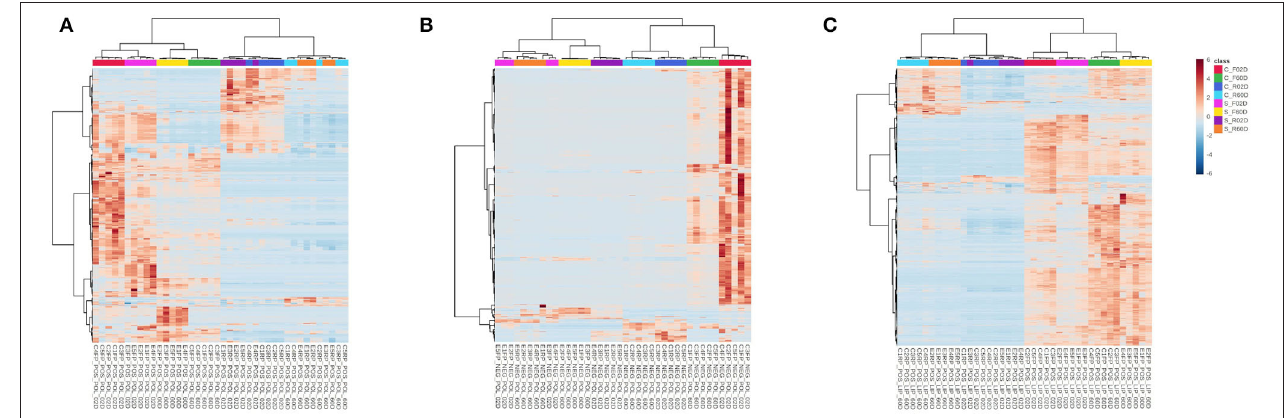
FIGURE 5 | Heatmap analysis of the all treatments data sets (control and stressed plants at 2 and 55 DAT). Blue color indicates low intensity and red color indicates high intensity. The upper row represents sample groups (C—Control, S—Stressed, F—Leaves, and R—Roots). Polar positive (A) , polar negative (B) , and lipidic positive (C)